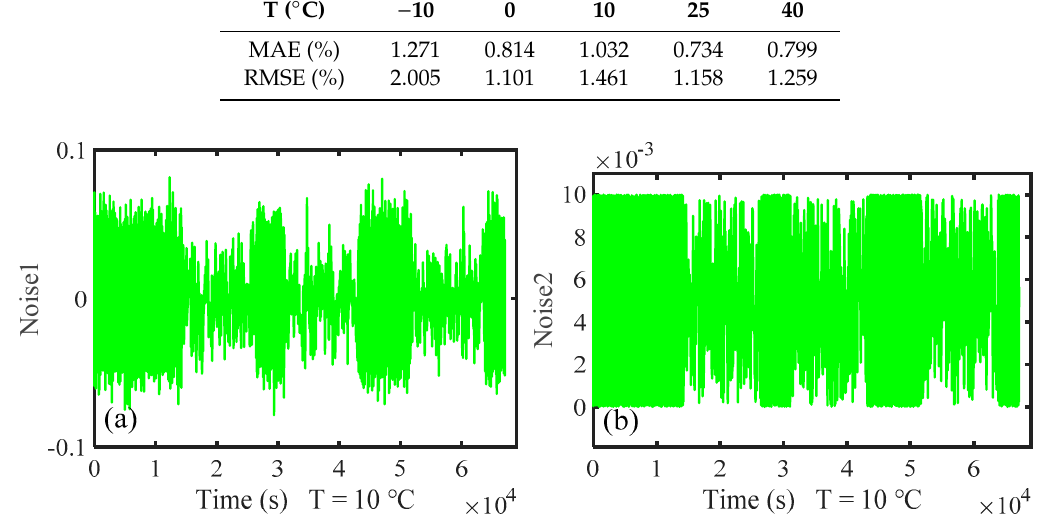
Figure 8. Two kinds of random noise: ( a ) Gaussian distributed noise, ( b ) uniformly distributed